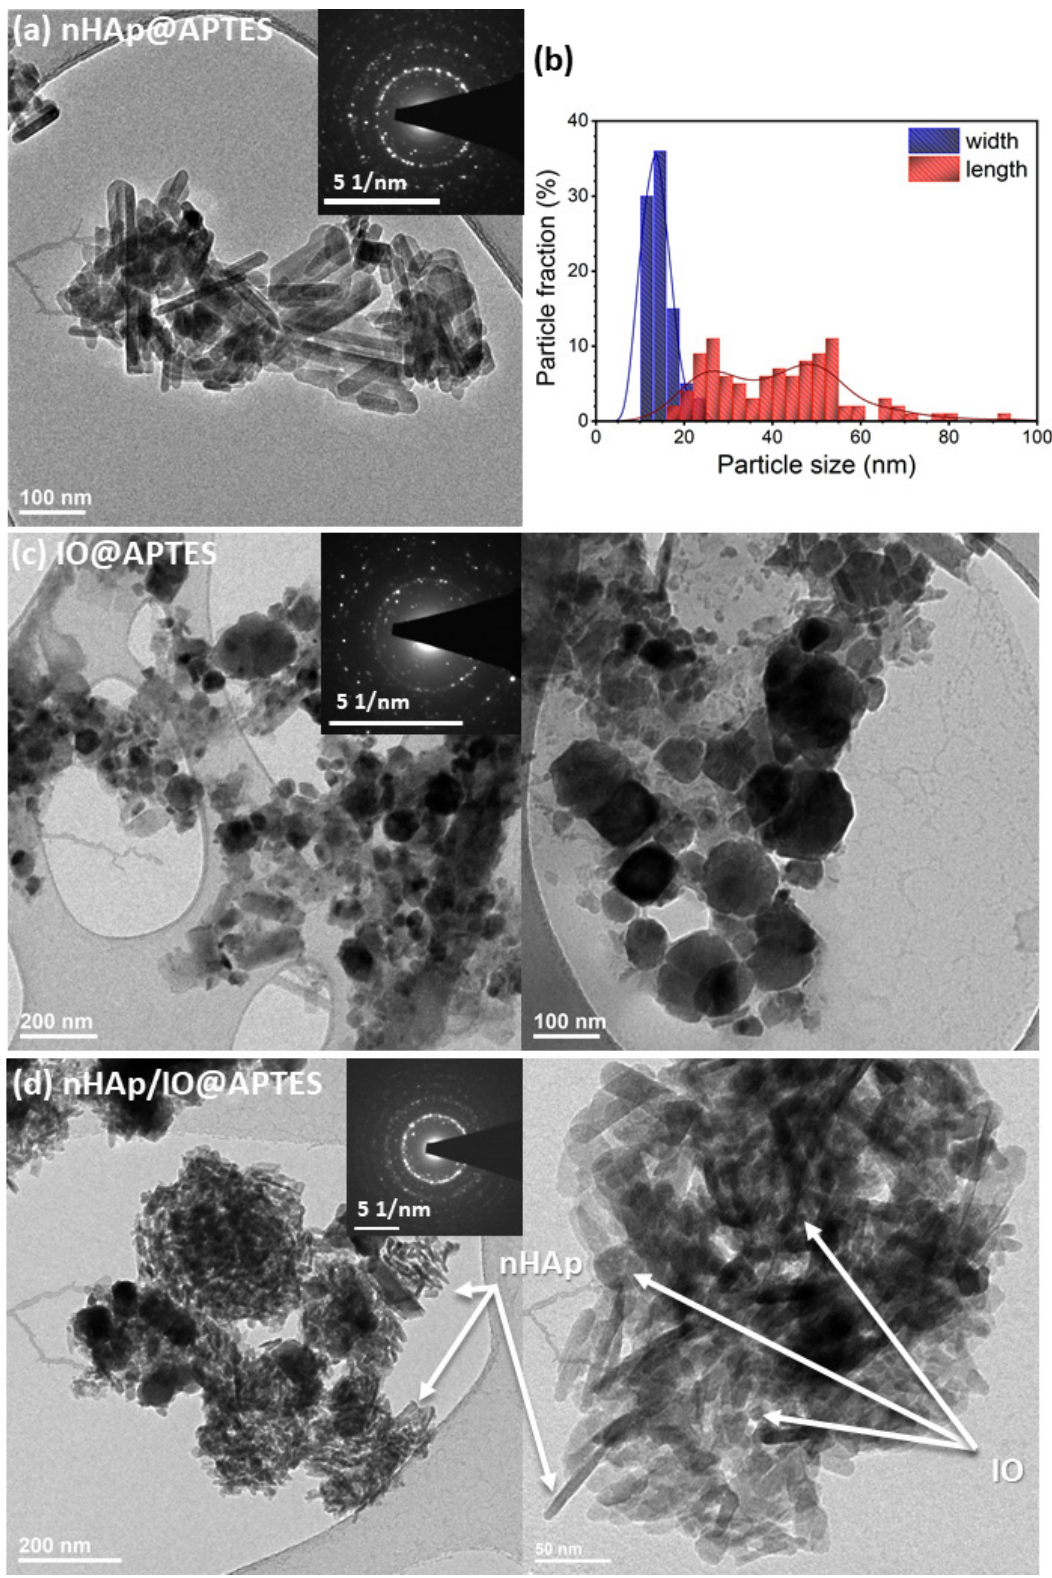
Figure 3. TEM and SAED (inset) images ( a , c , d ) of nHAp@APTES, IO@APTES and nHAp/IO@APTES, and the histogram ( b ) indicates the distribution of particles size of